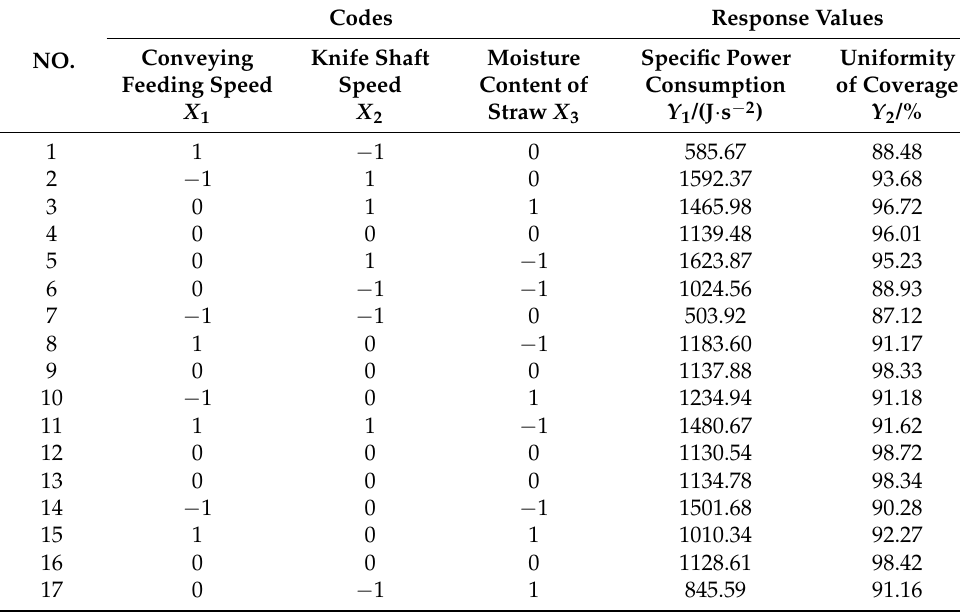
Table 3. Test design scheme and response value